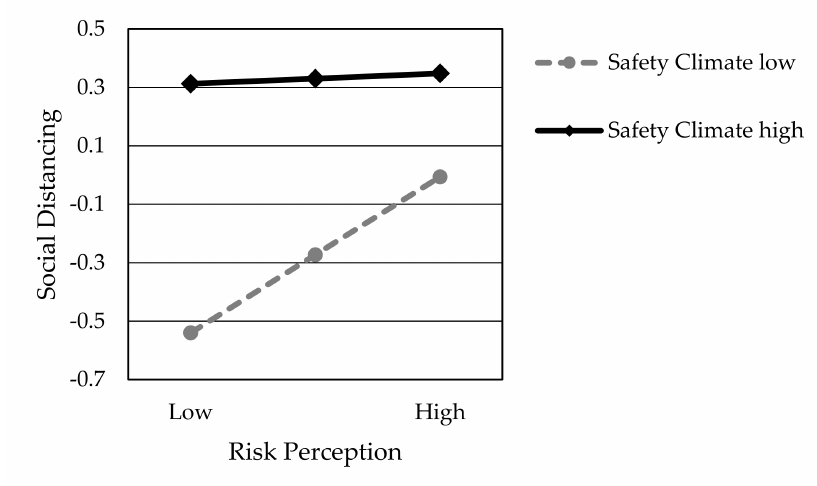
Figure 4. Safety Climate as a function of the interaction between Risk Perception and Social